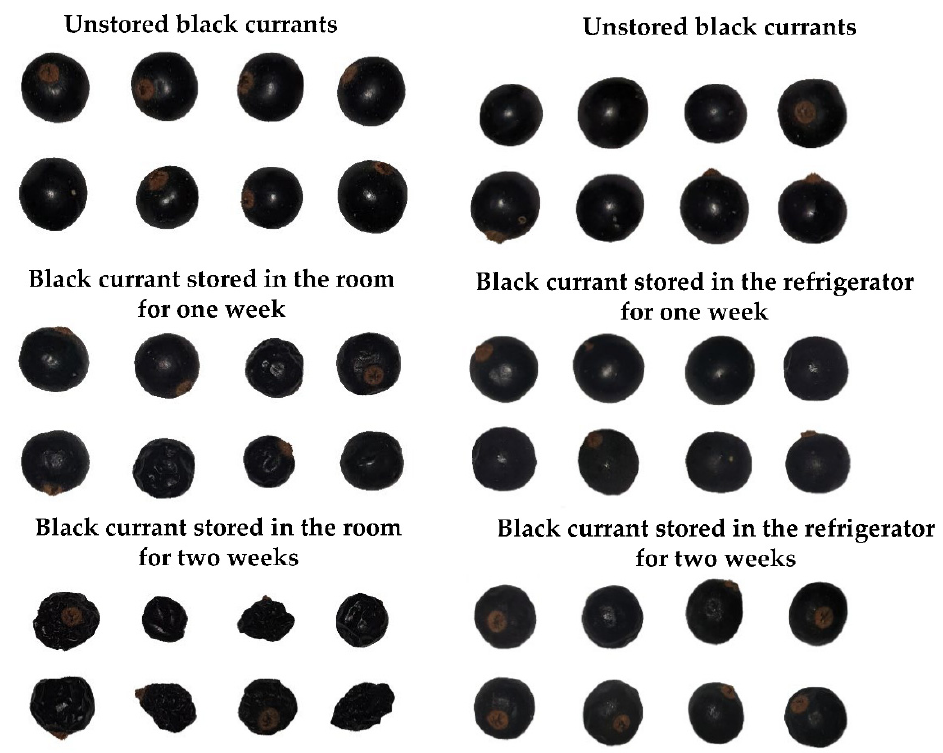
Figure 1. The images of unstored black currants at the beginning of experiments and samples stored in the room and the refrigerator for one week and two weeks. Table 1. The performance metrics of the classification of three classes of black currants (unstored, stored in the room for one week, and stored in the room for two weeks) based on models including selected image textures from color space RGB built using different